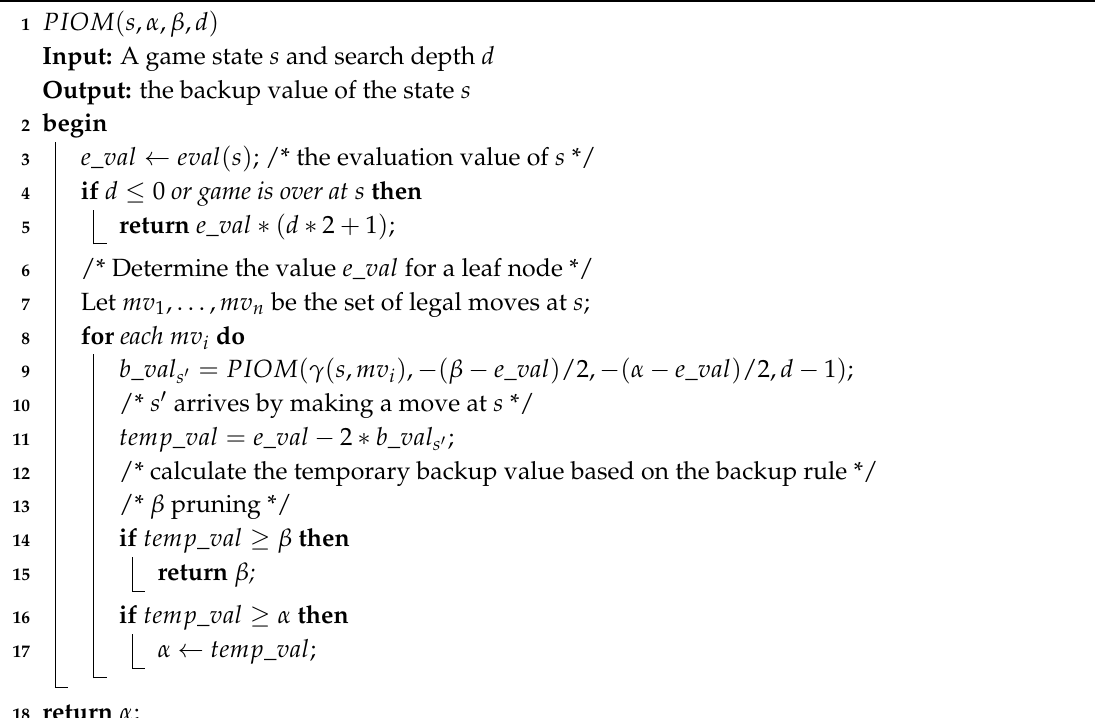
Figure 7. IOM algorithm with the alpha-beta pruning process. Algorithm 2: Alpha-beta pruning for iterative optimal minimax